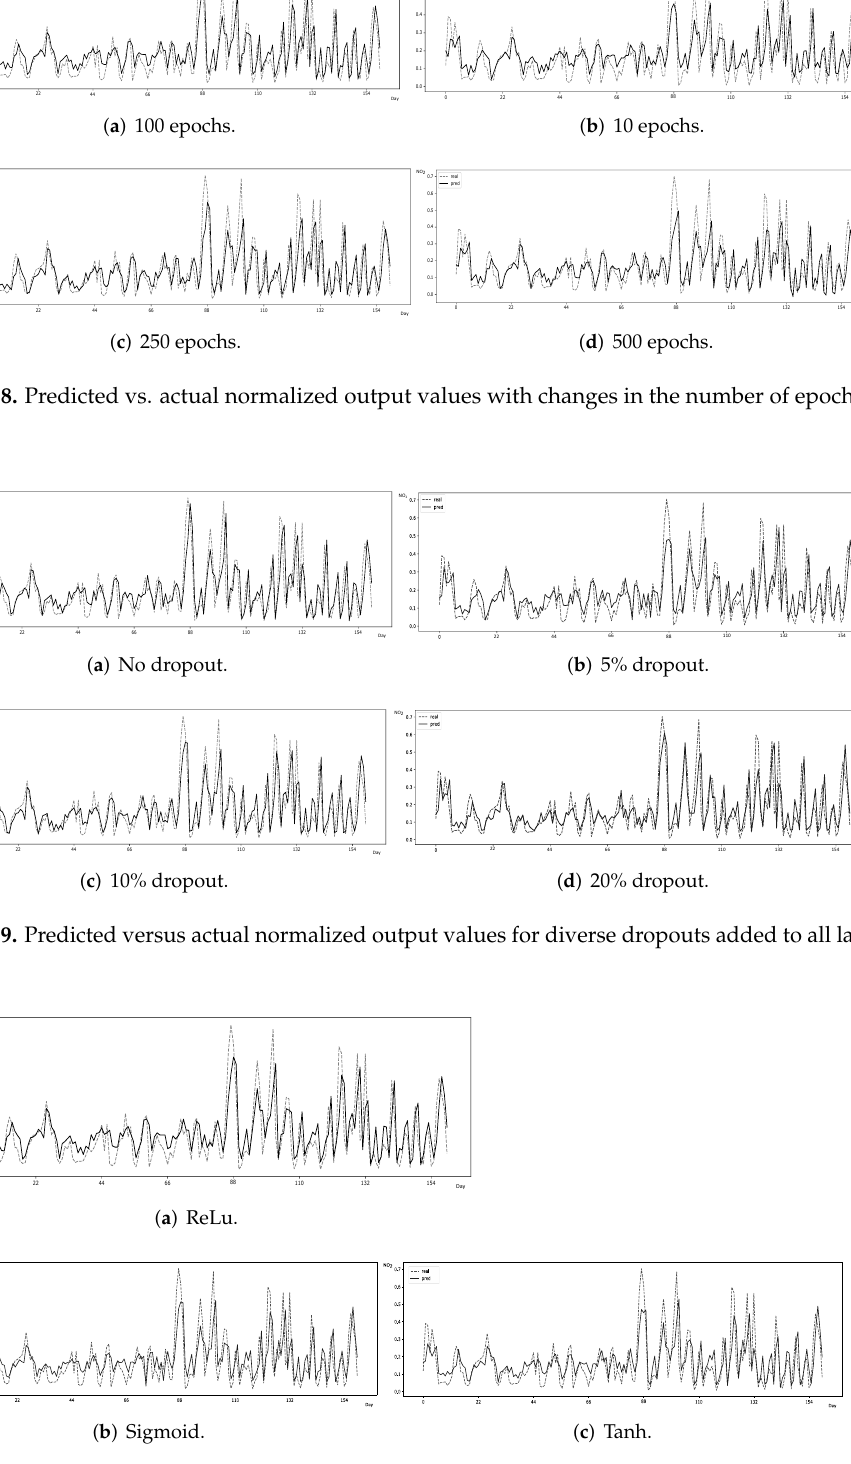
Figure 20. Predicted versus actual normalized output values considering different activation func- tions applied to the last dense